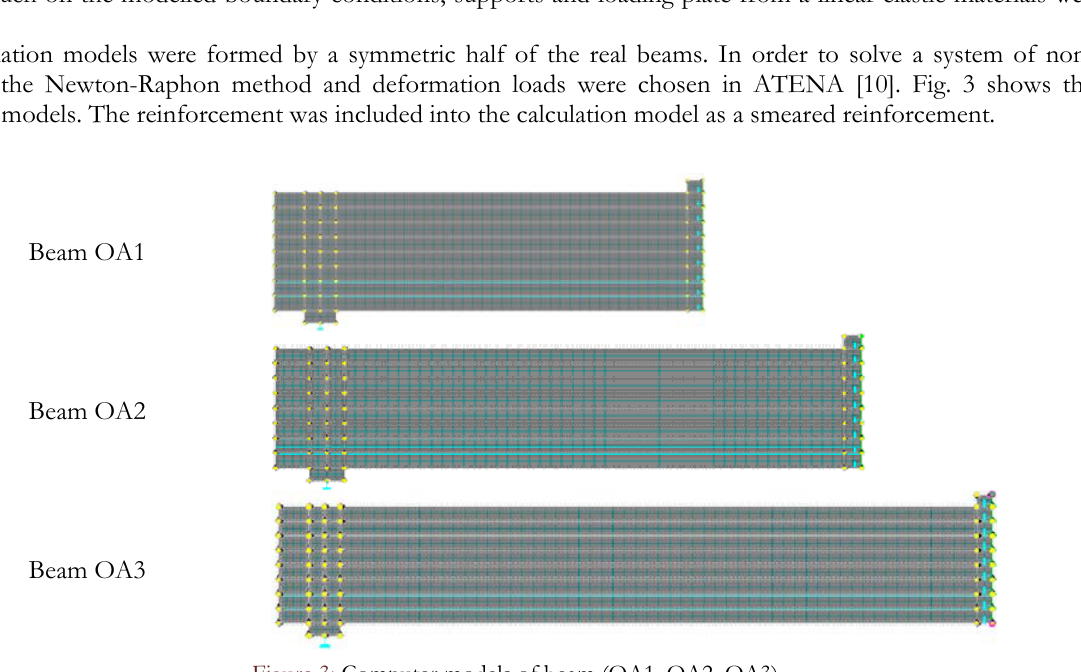
Figure 3: Computer models of beam (OA1, OA2, OA3).